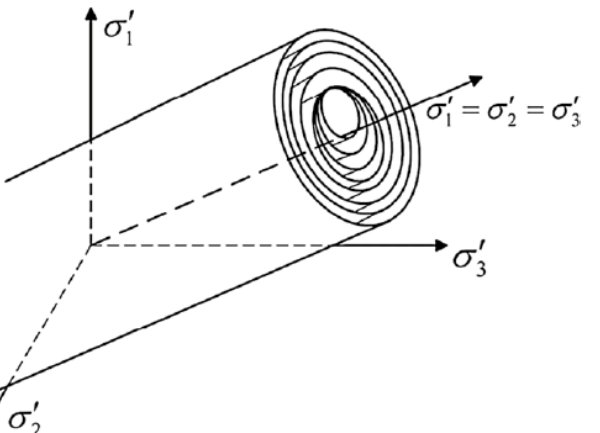
Figure 4. PressureIndependMultiYield (PMIY) model: multi-yield surfaces in principal stress space.